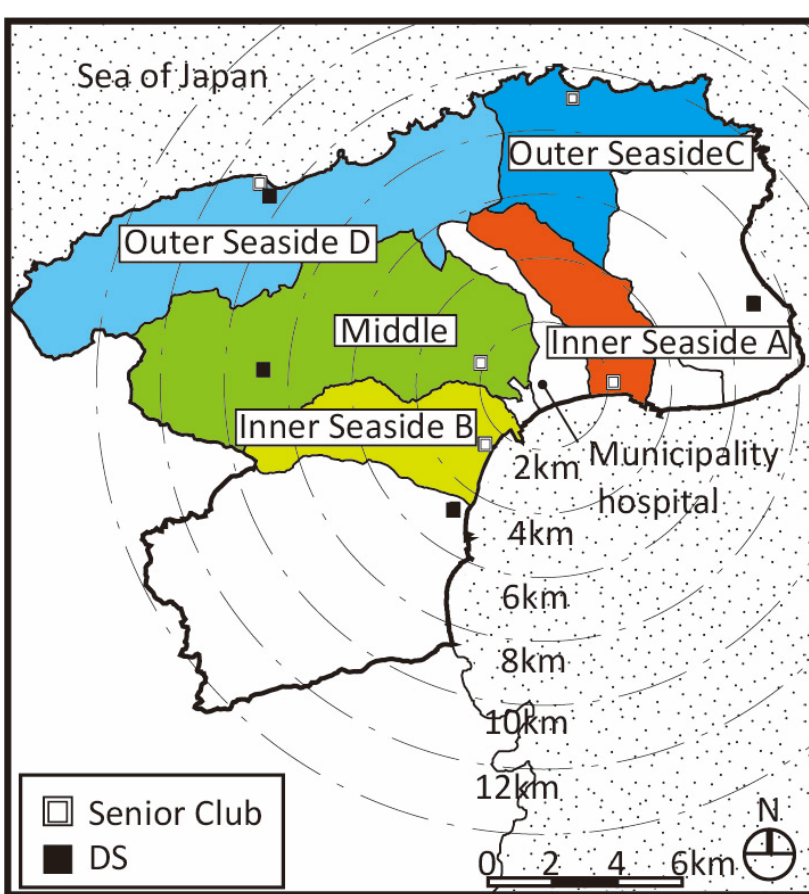
Figure 5. Five target districts in Suzu (unit: kilometers).